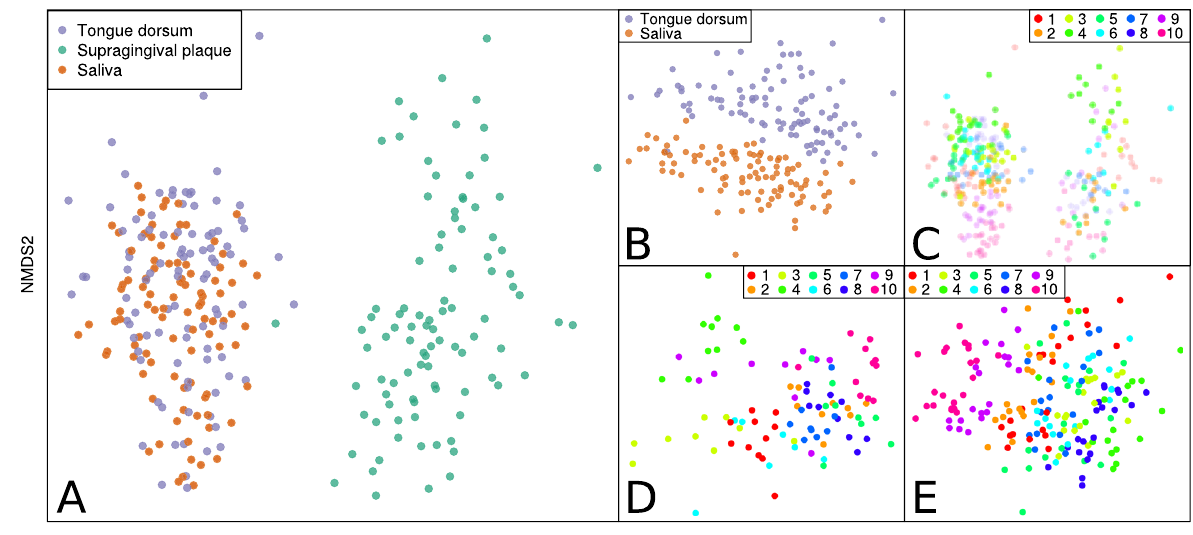
Fig. 1 NMDS ordinations of samples showing sample dissimilarity patterns under the Bray – Curtis measure. a All samples colored by oral site (stress value: 0.16). b Tongue and saliva samples colored by oral site (stress value: 0.20). c All samples colored by subject number (stress value: 0.16). d Supragingival plaque samples colored by subject number (stress value: 0.16). e Tongue and saliva samples colored by subject number (stress value: